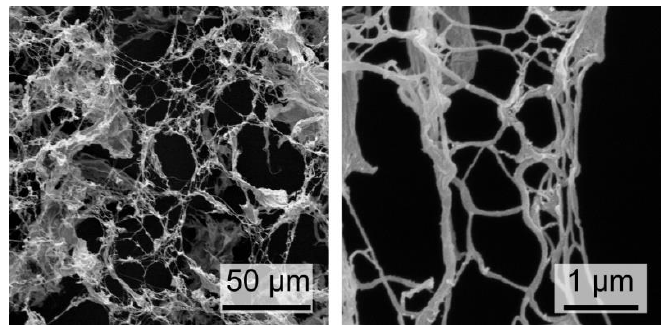
Figure 1. SEM images at different magnification of dry cellulose nanofibrils, after mechanical fibrillation using an ultra-fine friction grinder.